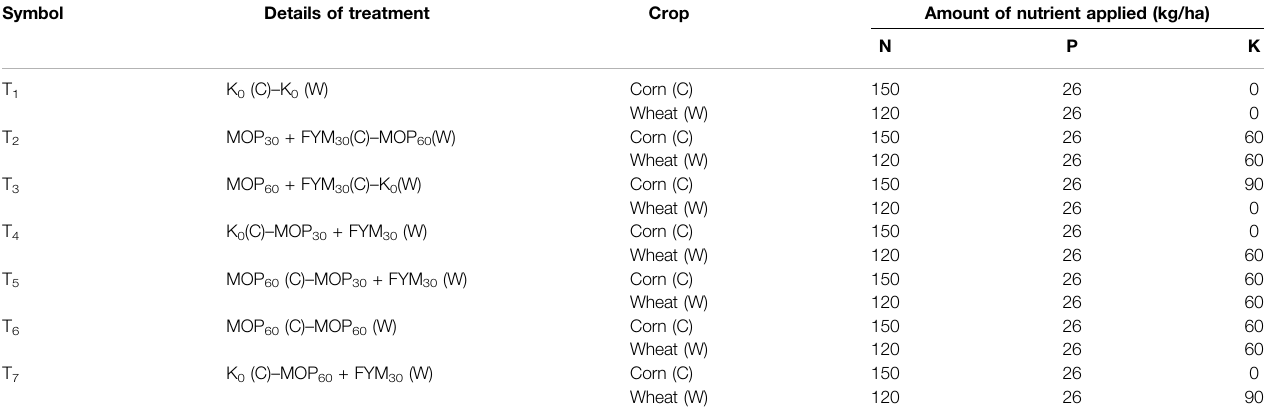
TABLE 1 | Experimental design of different treatments using FYM for integrated potassium fertilization under the corn – wheat cropping system. Symbol Details of treatment